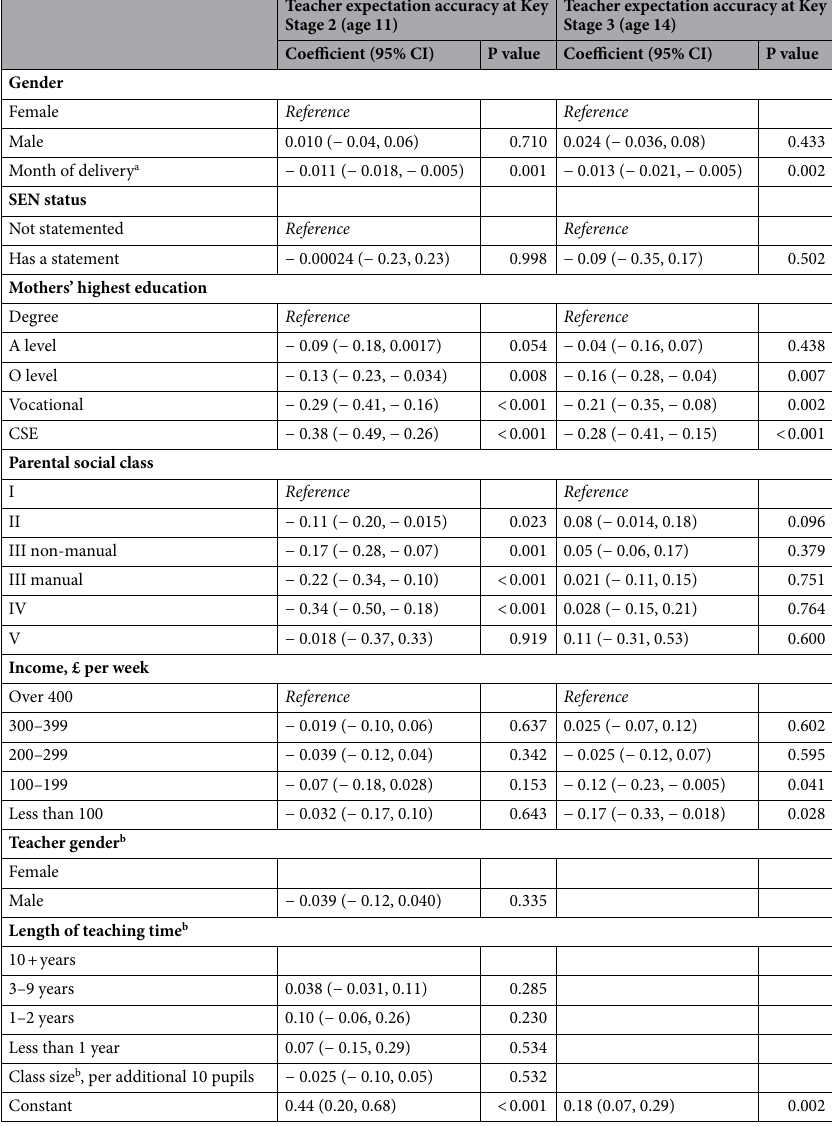
Table 2. Associations between teacher expectation, socioeconomic and demographic variables. Positive values reflect pupils who overperformed relative to their teacher’s expectations, while negative values reflect pupils who underperformed relative to their teacher’s expectations. Results for complete case analyses presented in Supplementary Table S1. a Where September = 1, October = 2 etc. to reflect the month of entry in UK schooling. b Data available for KS2